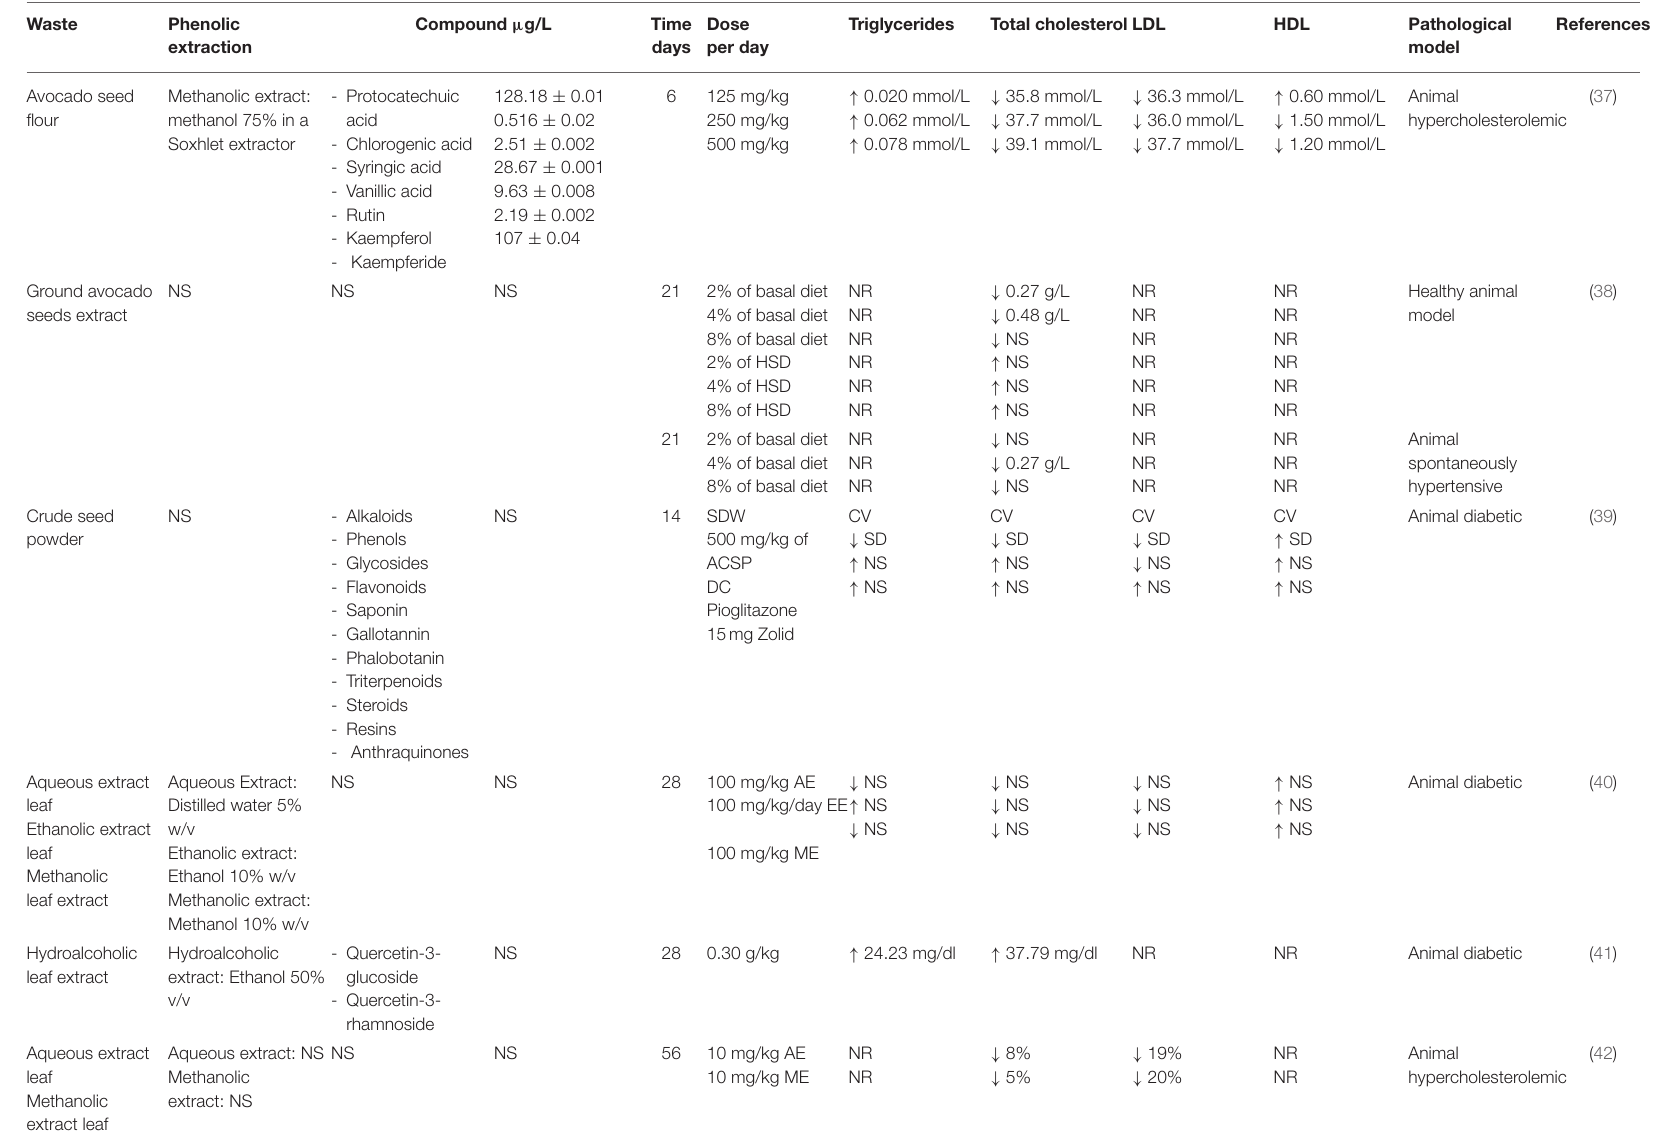
TABLE 1 | Phenolic method of extraction, compound content, and effect of avocado wastes used in experimental trials.